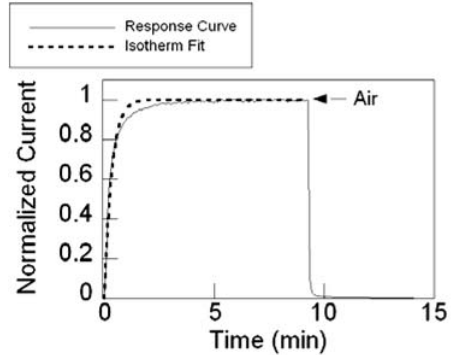
sensor to 0.5% H in N 2 2